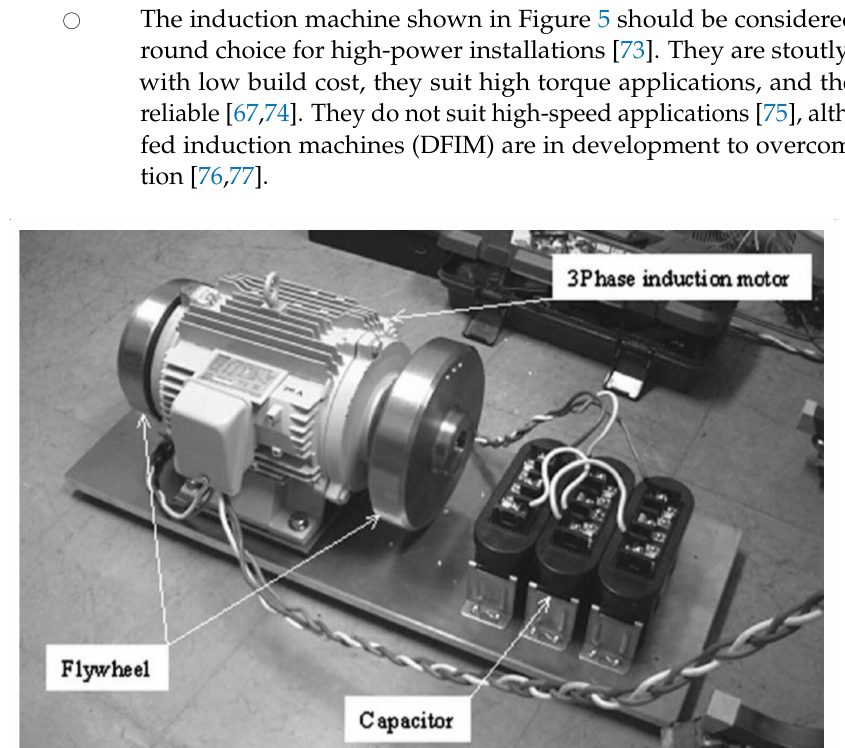
Figure 5. Flywheel energy storage system with an induction motor adapted from [73].